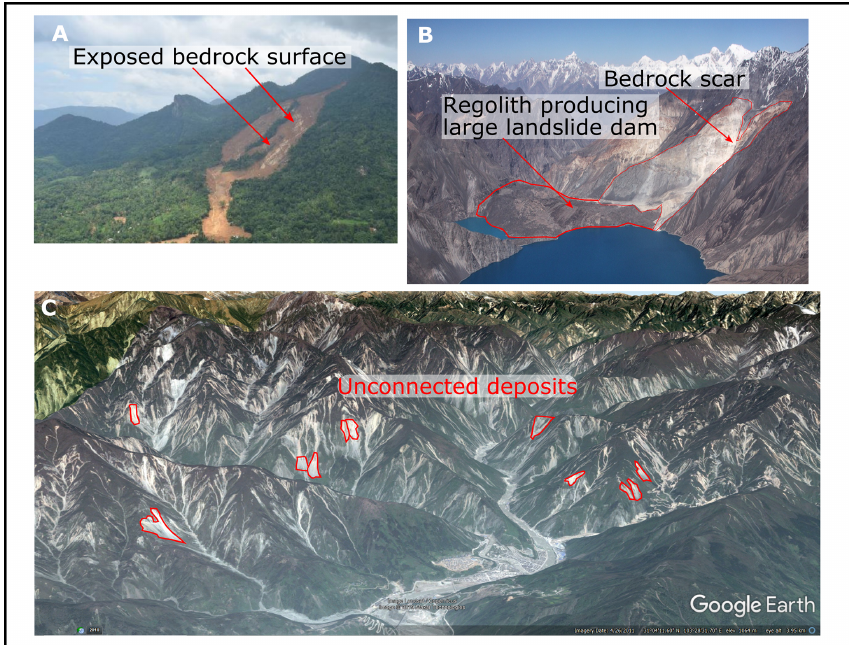
Figure 1. Landsliding can generate large volumes of sediment but only the largest consistently transport sediment off the hillslope. The volume of bedrock eroded is also dependent on the thickness of regolith on the hillslope before the landslide occurs. Panel (A) shows the 2016 Aranayake landslide in Sri Lanka which was triggered by intense rainfall in heavily weathered soils. The failure occurred along the regolith–bedrock interface and very little bedrock was eroded. Panel (B) shows that in bedrock-dominated areas, such as the Usoi Dam in Tajikistan (produced by the 1911 earthquake), significant volumes of regolith can be generated by landsliding but little measurable erosion as the regolith produced has remained in the catchment as a landslide dam for over 100 years. The 2008 Wenchuan earthquake produced over 60000 landslides (C) , many of which have significantly smaller transport lengths than the hillslope (highlighted in red) and so cannot be easily removed from the catchment. For these reasons, we define landsliding as weathering rather than as erosional agents. Panel (A) is sourced from https://blogs.agu.org/landslideblog (last access: 3 July 2020), (B) is from https://www.mergili.at/worldimages/picture.php?/9330 (last access: 3 July 2020), (C) is sourced from Google Earth, using imagery provided by Landsat/Copernicus and Maxar Technologies, 2019 and draped over a digital terrain model. © Google